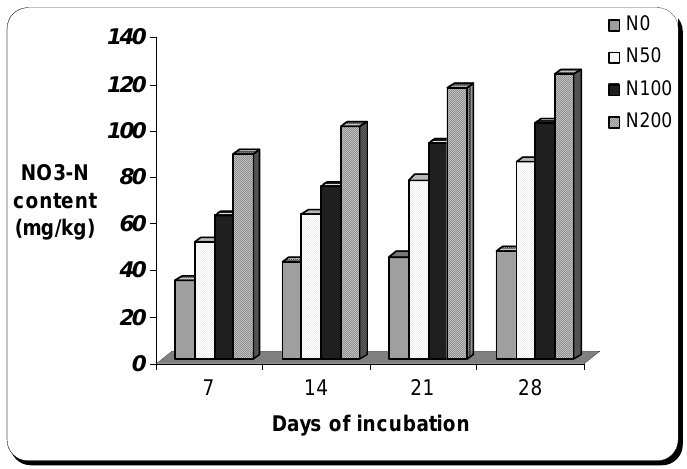
FIGURE 4. Mean effect of different levels of N on the changes in NO 3 -N content in soil under 60% WHC.